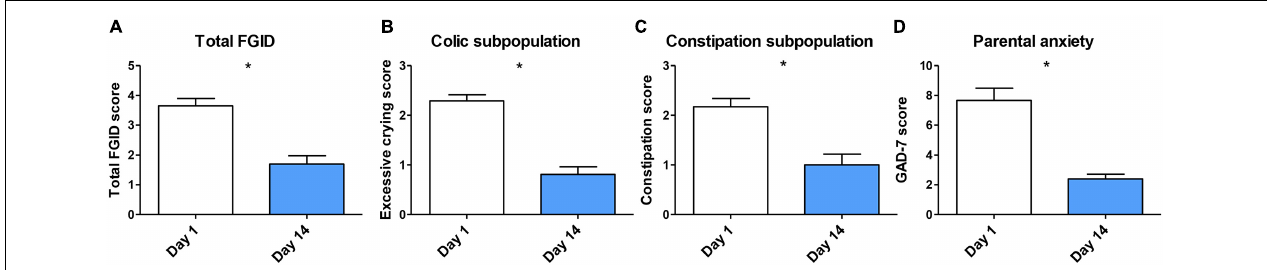
FIGURE 4 | (A) Overall FGID amelioration after probiotic treatment analyzed by ITT ( n = 36–32), missing data was filled with LOCF. PP analysis of (B) excessive crying reduction in colic subpopulation ( n = 26); (C) constipation reduction in constipation subpopulation ( n = 23); and (D) parental anxiety reduction ( n = 50) after treatment. Data are presented as means ± SD. Statistical differences were analyzed by Wilcoxon matched pairs test. * p <